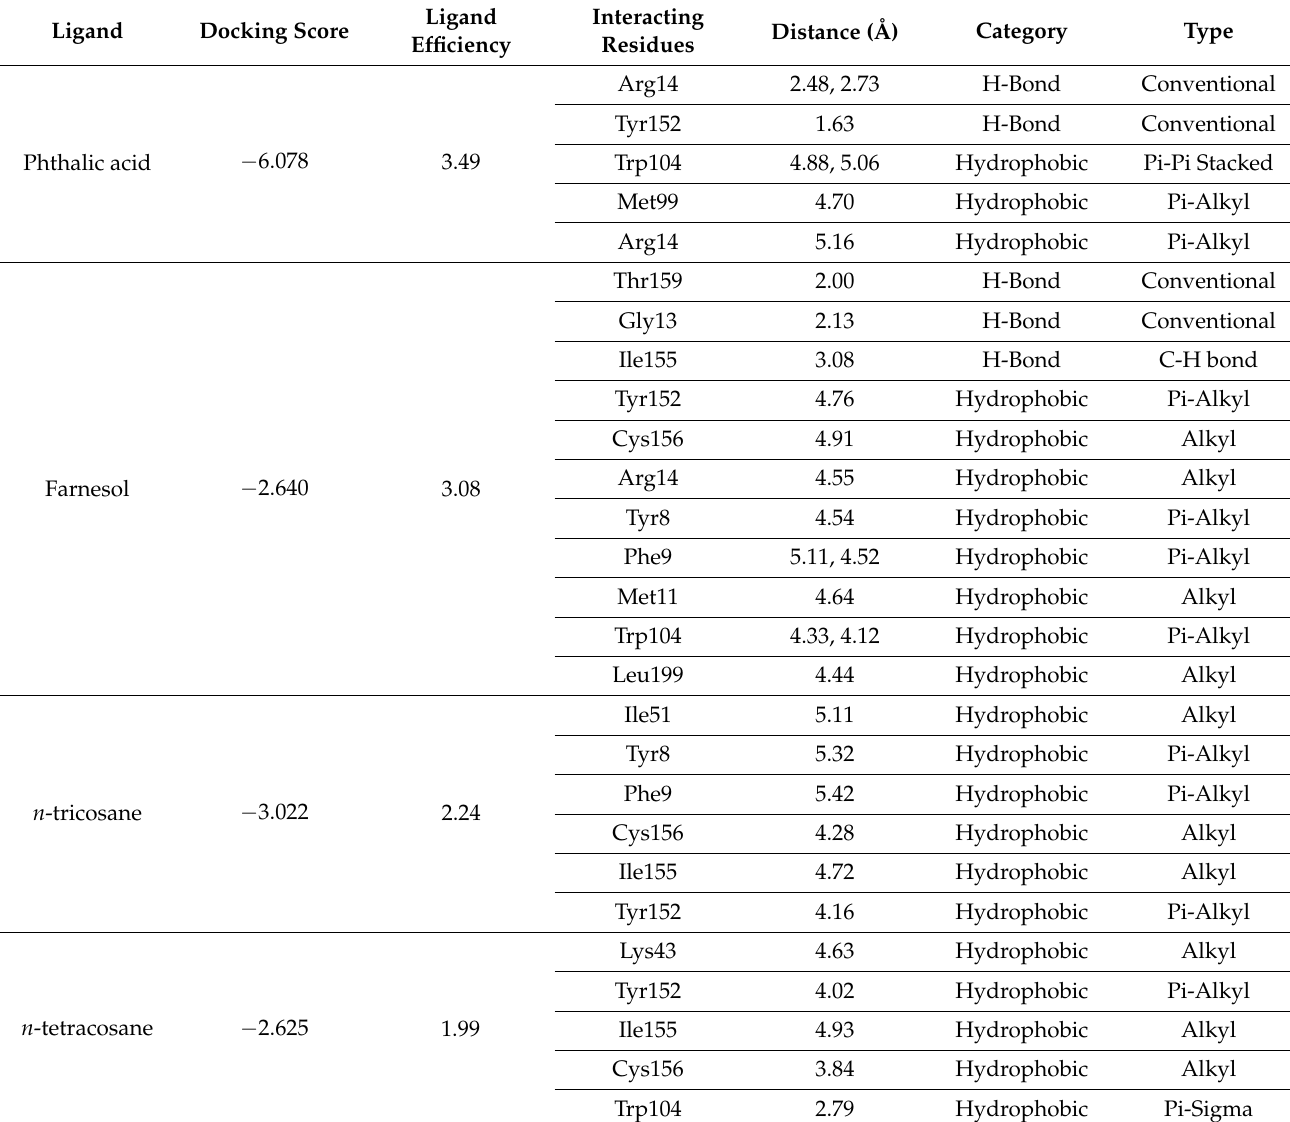
Table 2. Molecular interactions of L. indica phytochemicals showing the best ligand efficiencies for PGD 2 synthase 1